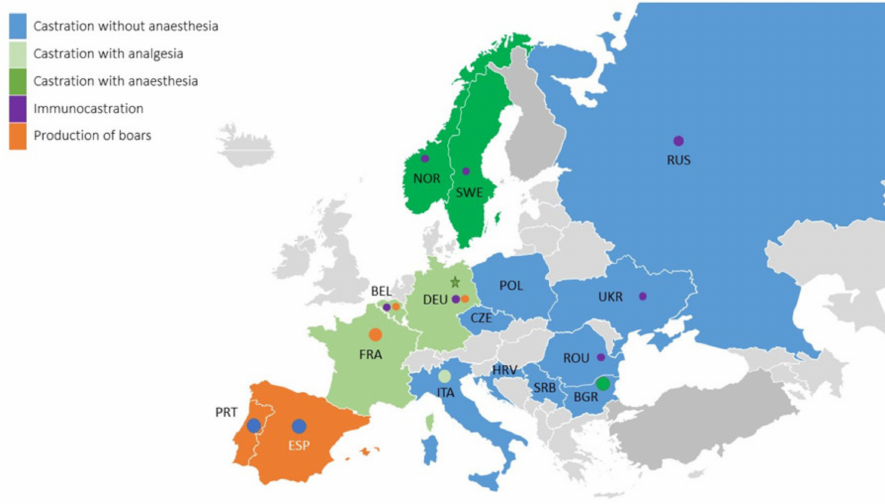
Figure 1. Currently applied production methods of male pigs for the countries included in this survey. Background colour indicates the main male pig production method and the dot indicates the additionally applied methods, whilst a star indicates the method as foreseen for implementation as main method in 2021 (source: based on [4], updated by the European Cooperation in Science and Technology (COST)